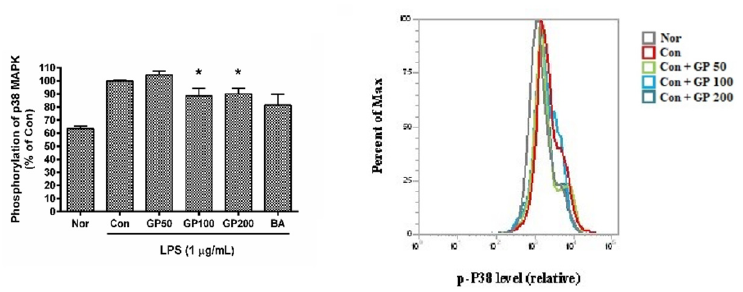
Figure 4. Effects of a combination extract of Gardeniae Fructus and Perillae Folium (GP) on the phosphorylation of P38 in LPS-activated RAW 264.7. Values are the mean ± SD of the three inde- pendent experiments. Nor, normal group (media only); Con, control group (LPS alone); BA, bai- calein (25 µM). GP25, GP50, GP100, and GP200 indicate 25, 50, 100, and 200 µg/mL of GP, respec- tively. * p < 0.05 vs. Con.